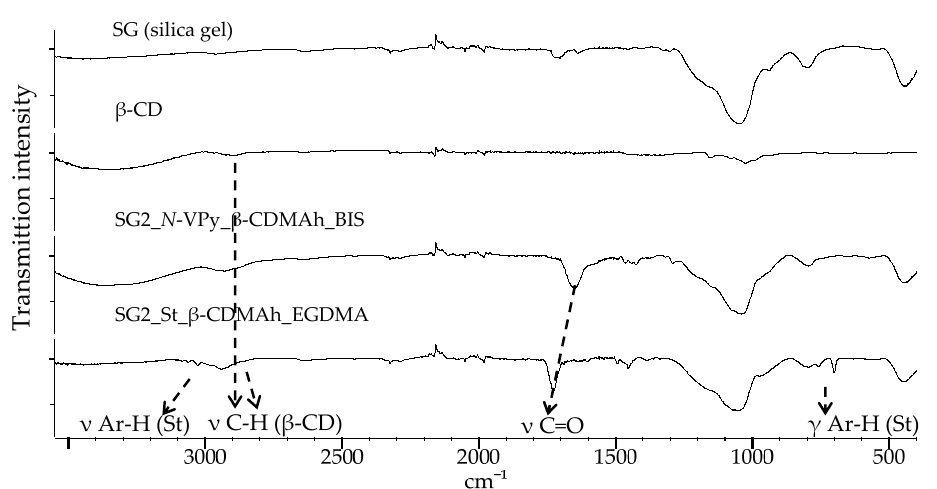
Figure 5. ATR-IR spectra: (top) silica gel; (middle) β -CD; (bottom) SG1_N-VPy_ β -CDMAh_BIS. The IR spectrum of an analogous polymer on silica gel modified using method 2 (SG2_ N- VPy_ β -CDMAh_BIS) is shown in Figure 6.